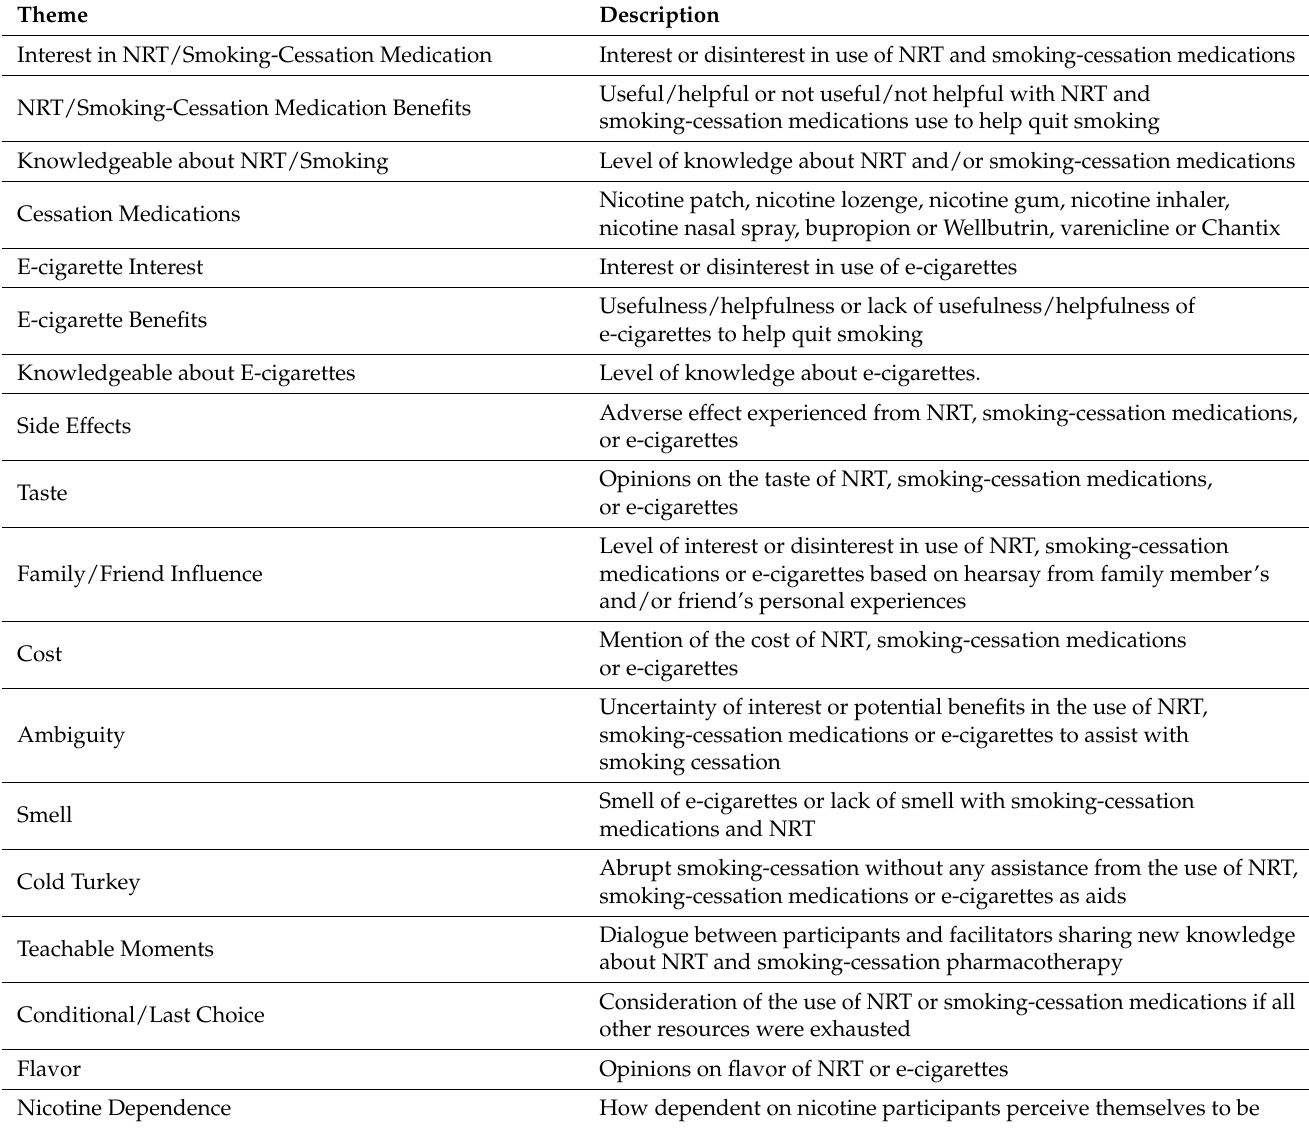
Table 2. Themes identified in the Commune Smokefree Social Facebook groups regarding smoking- cessation pharmacotherapy and